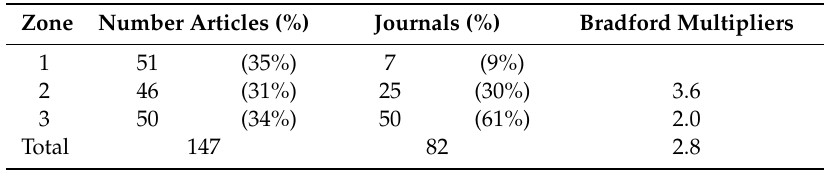
Table 3. Bradford zones.